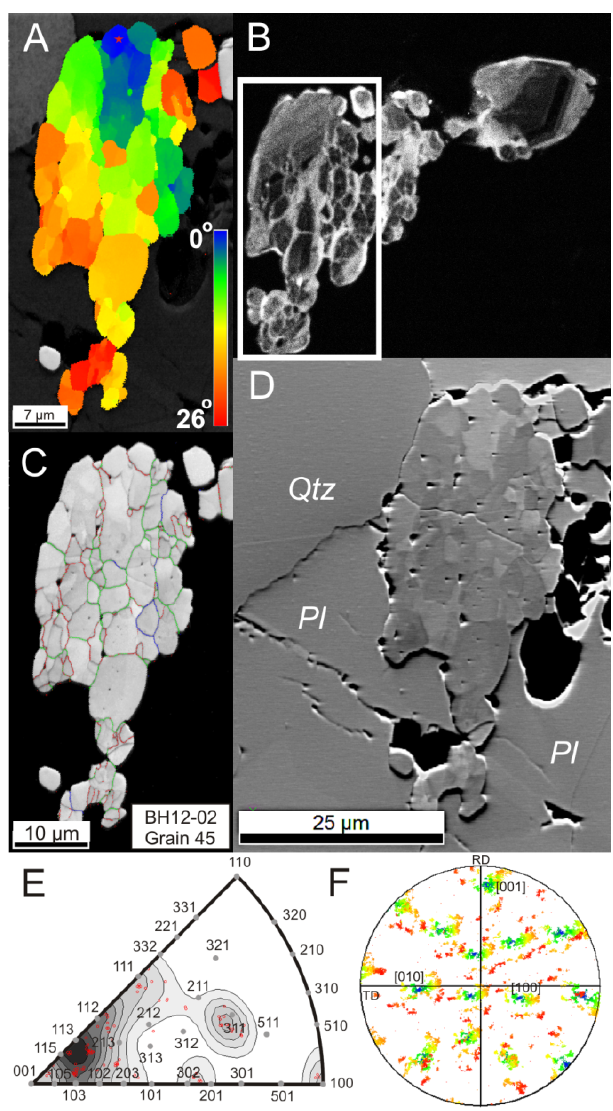
Figure 8. Grain BH12-02_45, lattice distortion type (III) case 5. (a) EBSD map color-coded for zircon misorientation with respect to a reference point (red star marker). (b) CL image (white rectangle marks position of EBSD map). (c) EBSD pattern quality map with subgrain boundaries colored for misorientation angles between sub- grains (red: 2–5 ◦ ; green: 5–15 ◦ ; blue: > 15 ◦ ). (d) FSE image; Qtz: quartz; Pl: plagioclase. (e) Inverse pole figure plot of the misorien- tation axes distribution density. (f) Pole figure plot showing zircon crystal directions (lower-hemisphere equal area projection) colored as in (a) . Labels indicate the crystallographic directions.